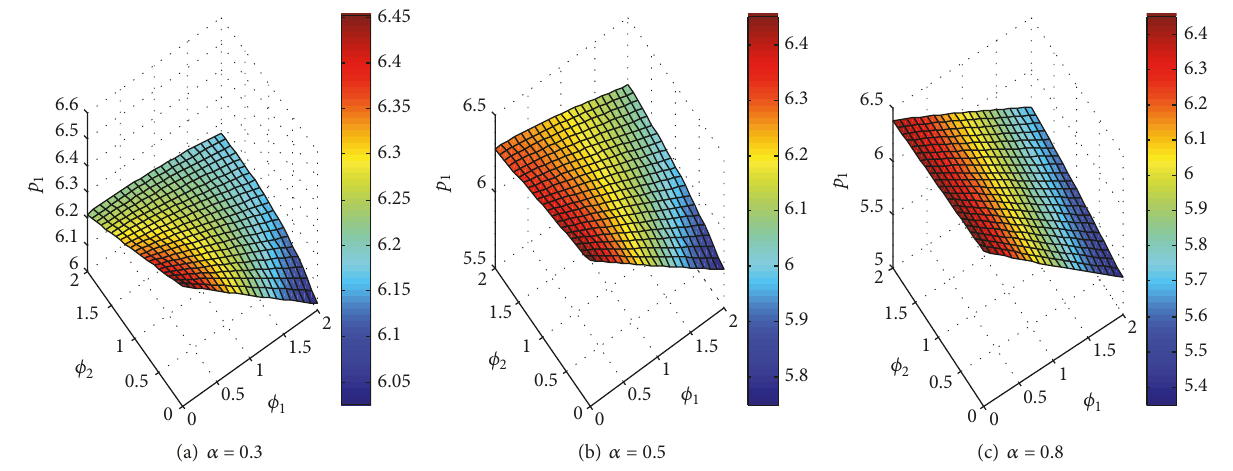
Figure 4: The impact of fairness concern on player 1’s price p 1